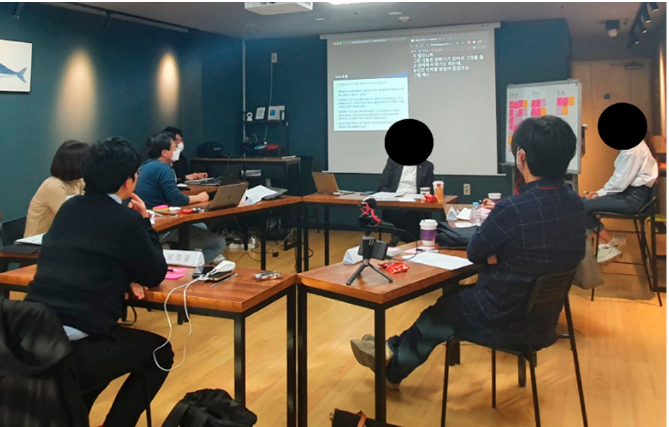
Figure 1. Example of a focus group interview (FGI) (session for people with hearing impairments).